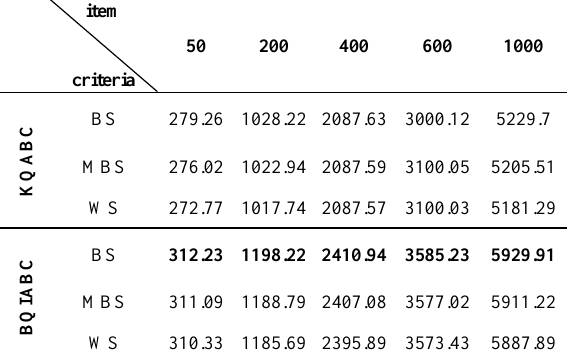
Table 4. Comparison between BQIABC and KQABC.